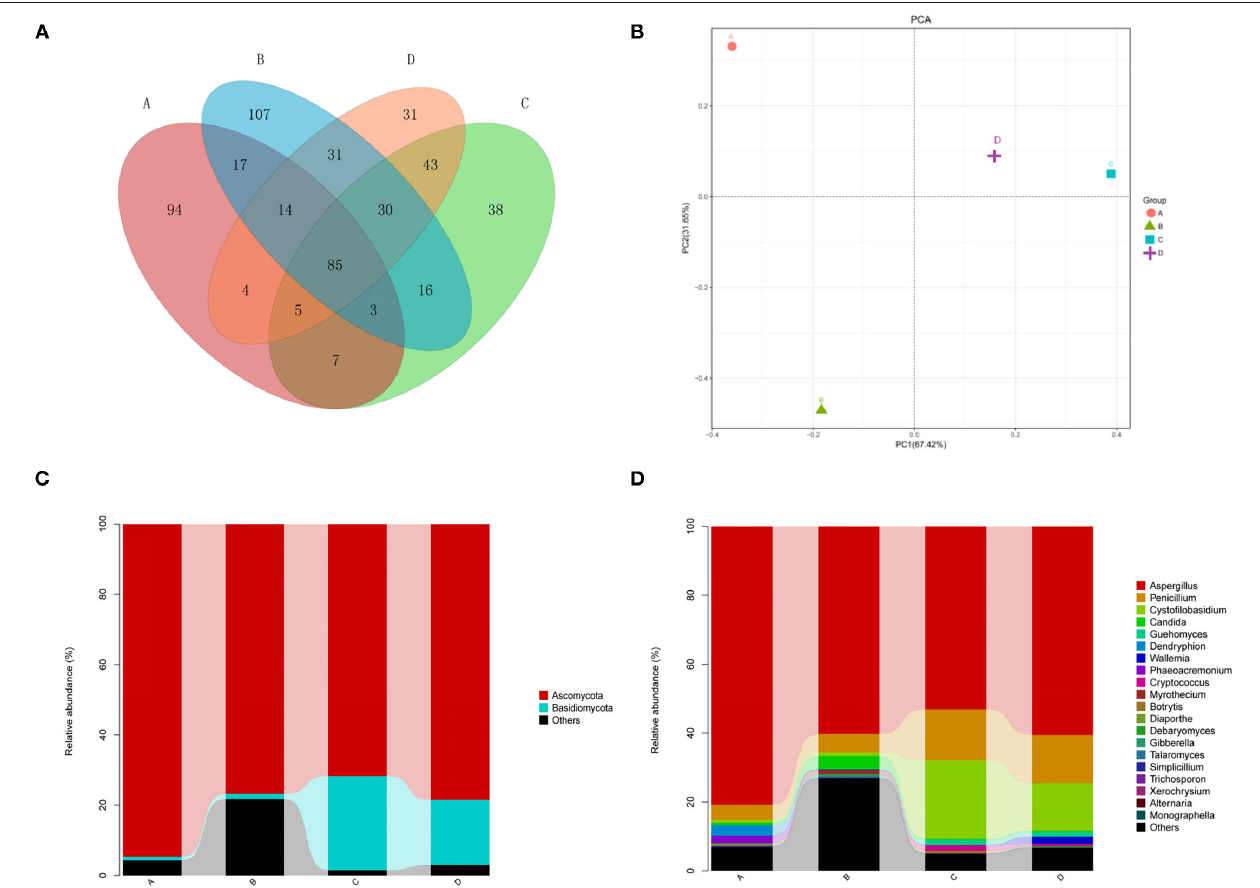
FIGURE 1 | (A) Venn diagram showing the distributions of operational taxonomic units (OTUs) across 4 groups. Astragalus membranaceus samples under fermentation with Enterococcus faecium. E. faecium (A), Lactobacillus plantarum (B), E. faecium + L. plantarum (C), and LBS (D) on day 6. (B) Two-dimensional principal component analysis plot of the samples. A. membranaceus samples under fermentation with E. faecium (A), L. plantarum (B), E. faecium + L. plantarum (C), and LBS (D) on day 6. (C) Phylum levels in samples. A. membranaceus samples under fermentation with E. faecium (A), L. plantarum (B), E. faecium + L. plantarum (C), and LBS (D) on day 6. (D) Genus levels in samples. membranaceus samples under fermentation with E. faecium (A), L. plantarum (B), E. faecium + L. plantarum (C), and LBS (D) on day